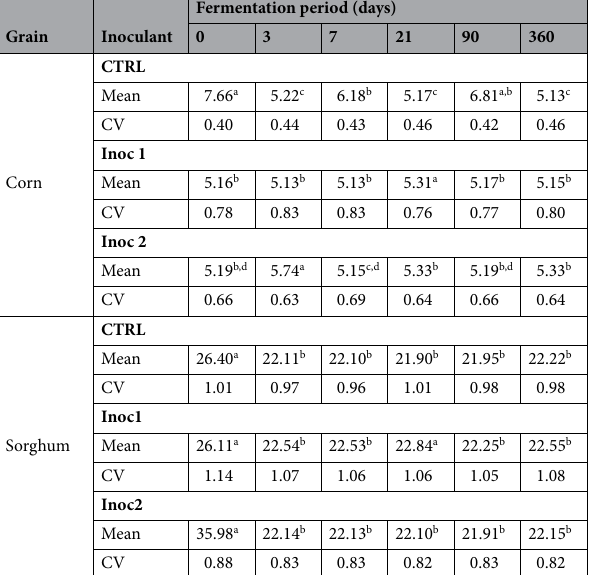
Table 3. Study of each inoculant throughout the fermentation period for the bacterial abundance of ground and rehydrated corn and sorghum grain silages after 0, 3, 7, 21, 90 and 360 days of fermentation. CTRL non- inoculated, Inoc1 Lactobacillus plantarum and Propionibacterium acidipropionici , Inoc2 Lactobacillus buchneri. a−e Means followed by different letters in the line differ by credibility